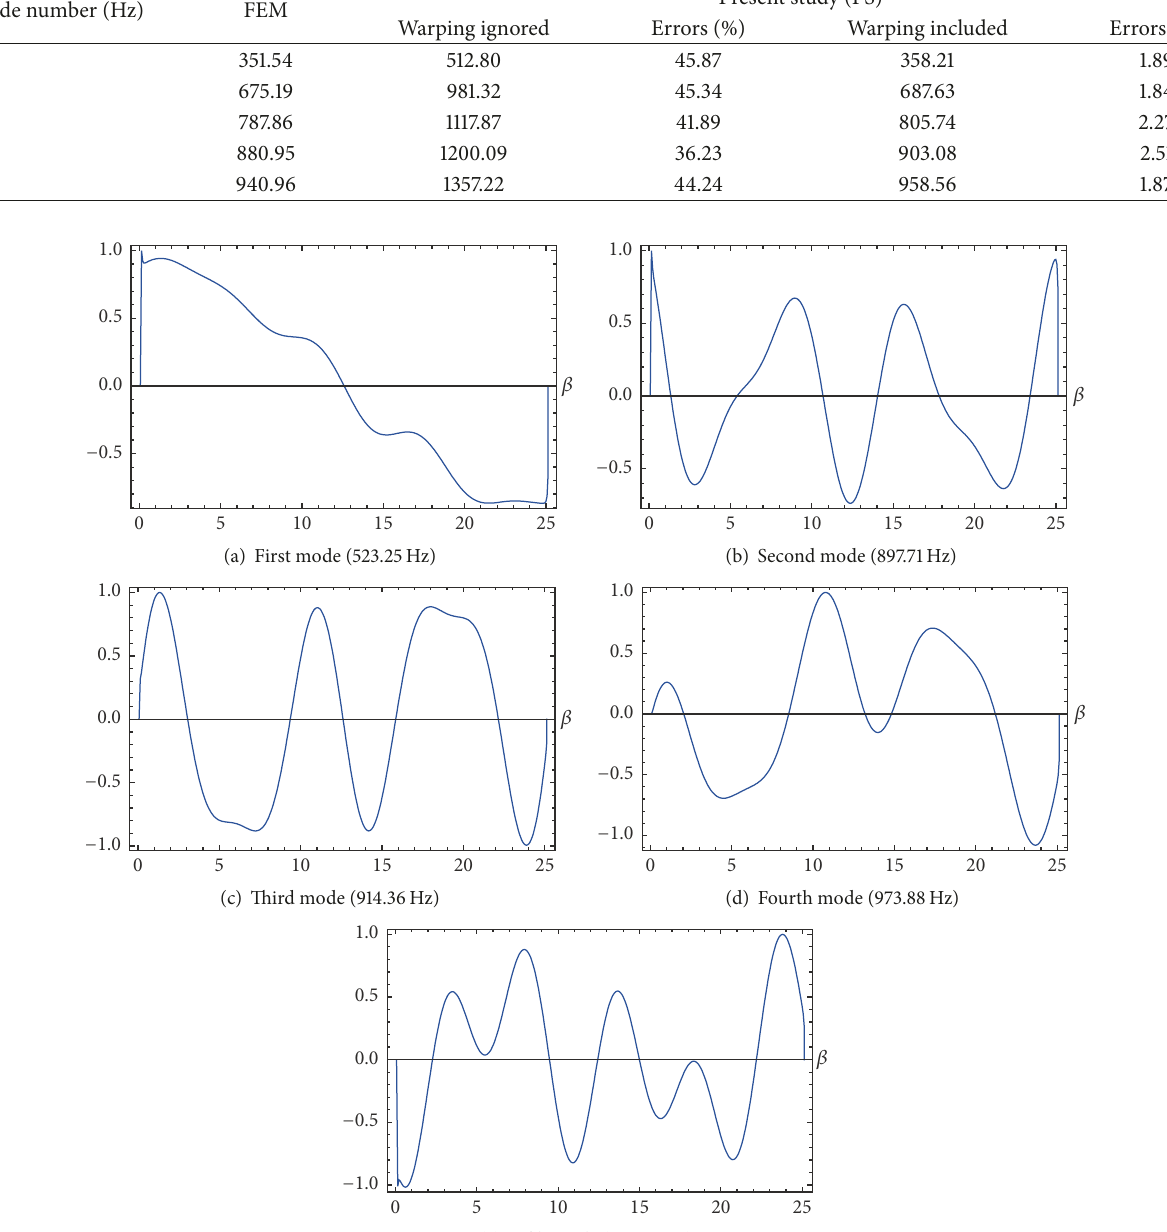
Figure 6: First five normal mode shapes of the generalized warping coordinate of Beam